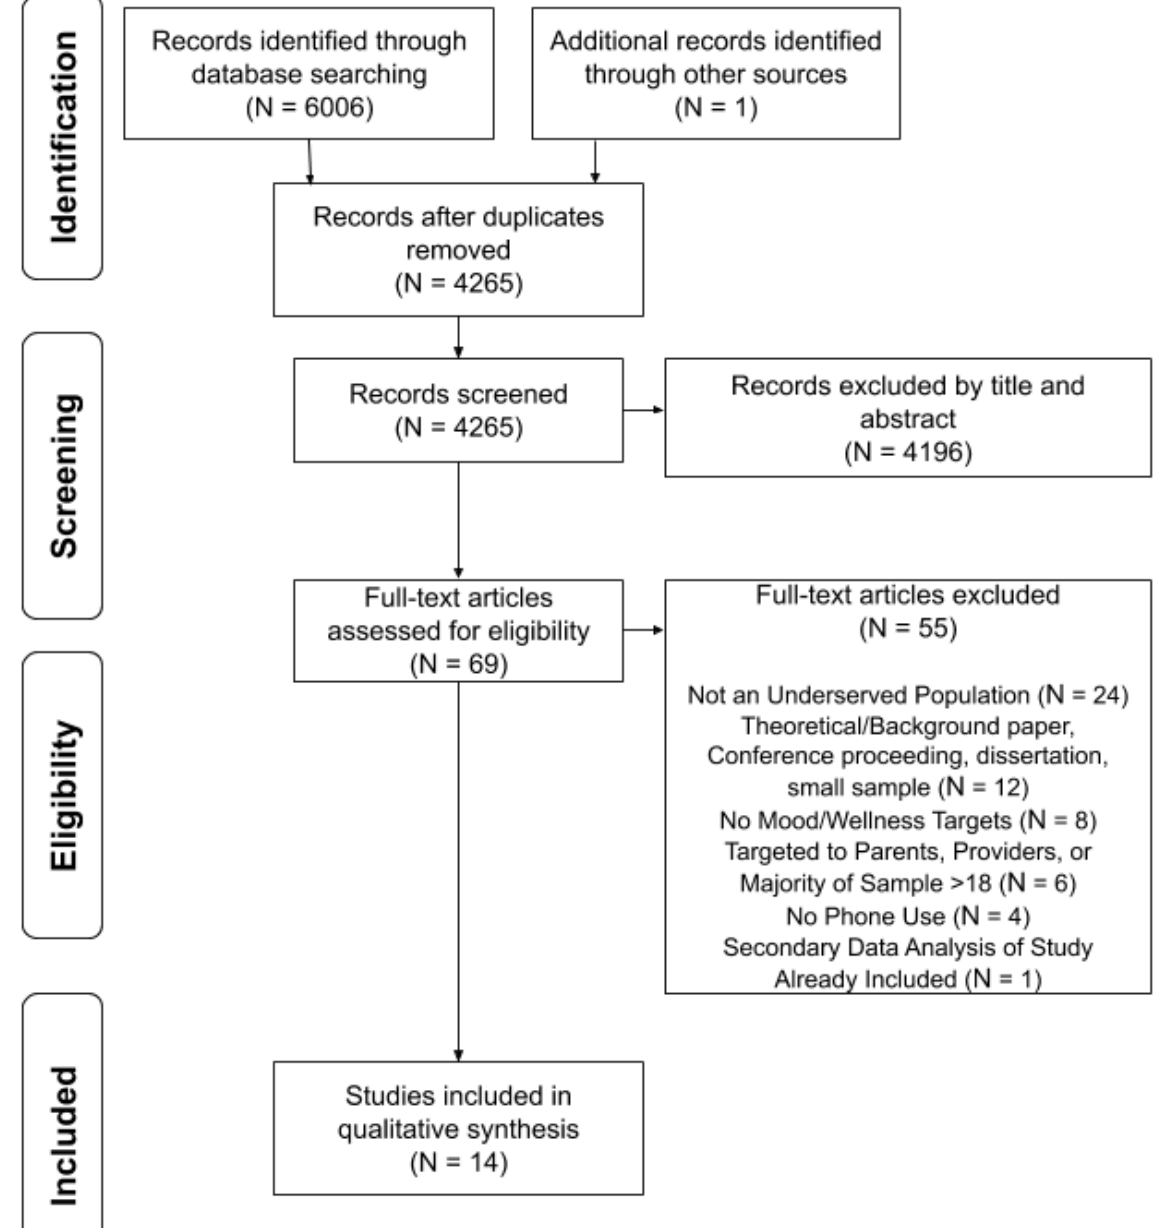
Figure 1. PRISMA flow diagram for study inclusion. aAdapted from “Preferred Reporting Items for Systematic Reviews and Meta-Analyses: The PRISMA Statement,” by D. Moher, A. Liberati, J. Tetzlaff, D. G. Altman, and The PRISMA Group, 2009, PLoS Med. 6(7),